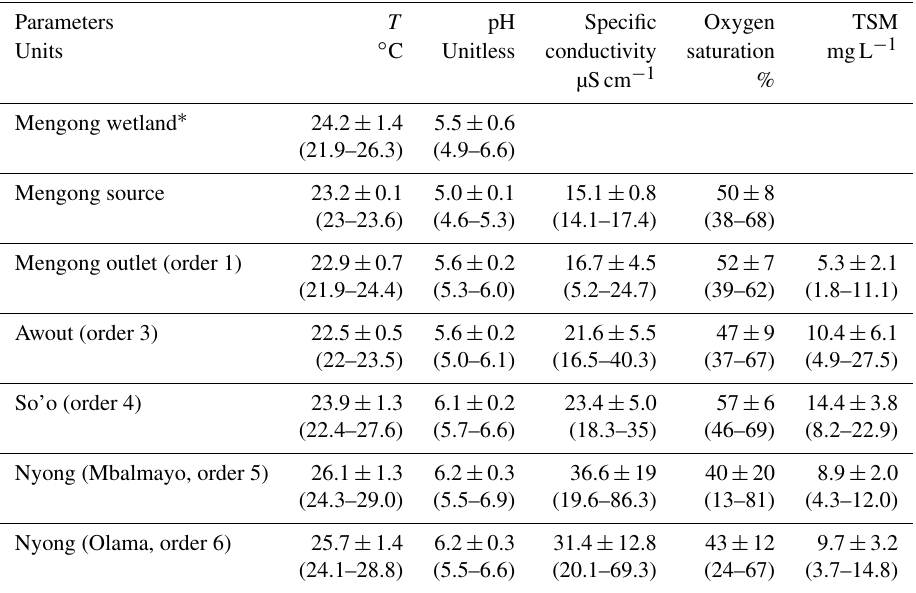
Table 2. Spatial distribution of physicochemical parameters (yearly average ± standard deviation) in waters of the Nyong watershed during the sampling year 2016. The range is shown in square